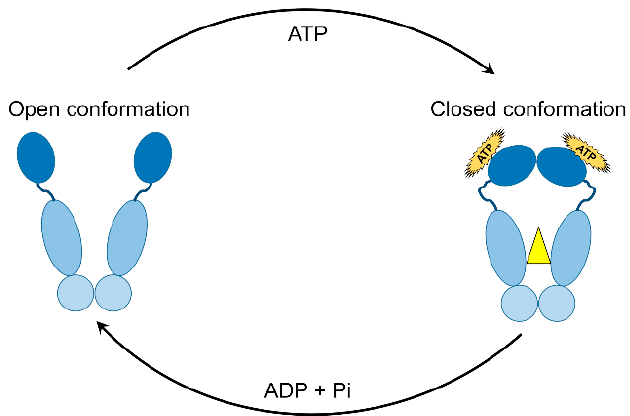
Figure 2. Schematic representation of the ATPase cycle of HSP90. The open and closed conformations of HSP90 are depicted.